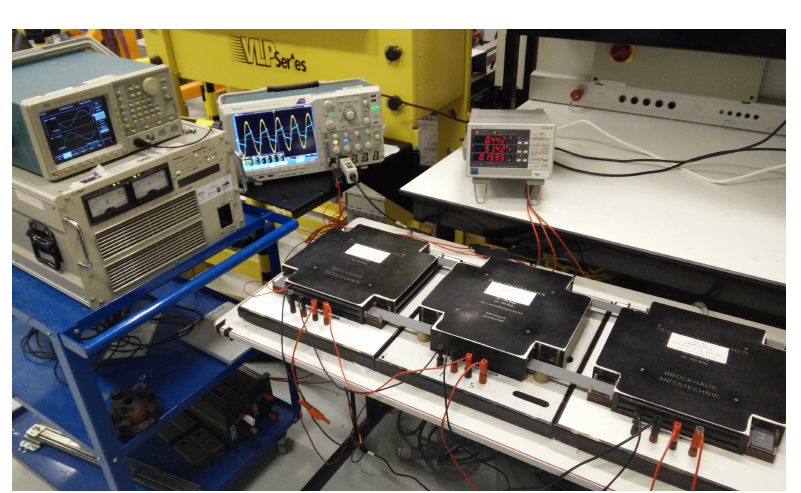
Figure 2. Experimental test bench with the long